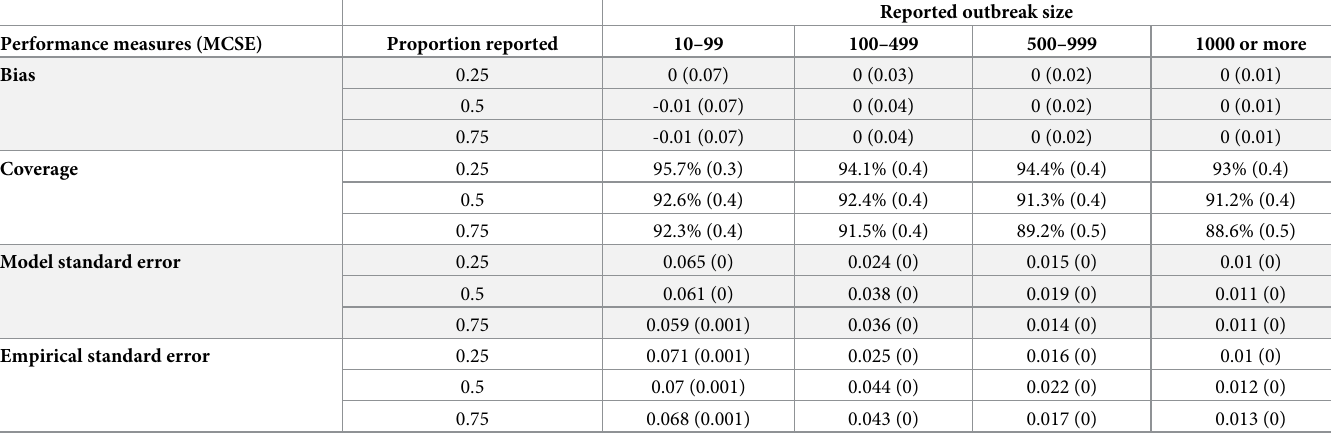
Reported outbreak size